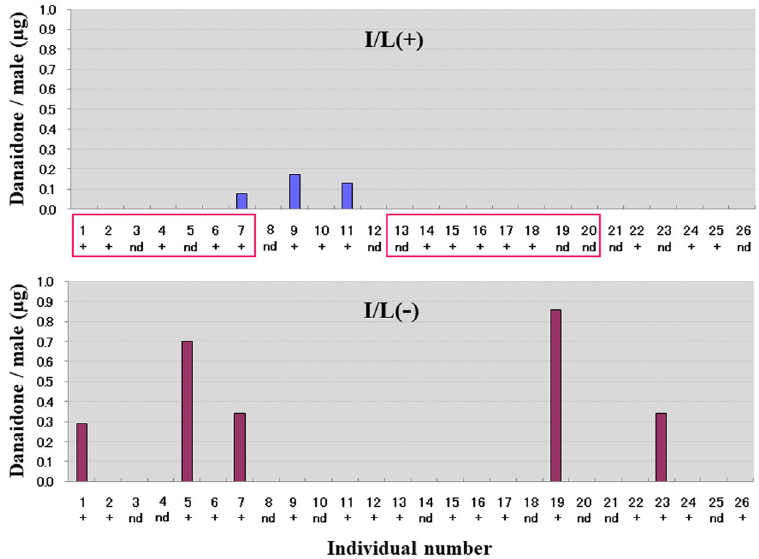
Figure 4. Individual variation of the amount of DO retained in the hairpencils of I/L-fed and I/L-unfed males of Parantica sita that participated in the mating competition. Data obtained from Runs 1 and 2 (Fig. 3) are collectively shown. DO determination was conducted on the day following copulation for mated males or on the day following termination of the experiment for unmated males. Stock males kept for replacement were also used for DO measurement, where appropriate. In cases where DO content was too low to quantify on GC, its presence ( + ) was confirmed by MS. nd, not detected. This, however, does not necessarily mean that the males in question were totally devoid of DO at the commencement of the experiment. The individual numbers in red squares denote males that achieved copulation. Prior to the experiment, both I/L-fed and I/L-unfed males had been equally fed retronecine (1.5 mg each), which can be a common precursor for both sex pheromone components (DO and 7 R